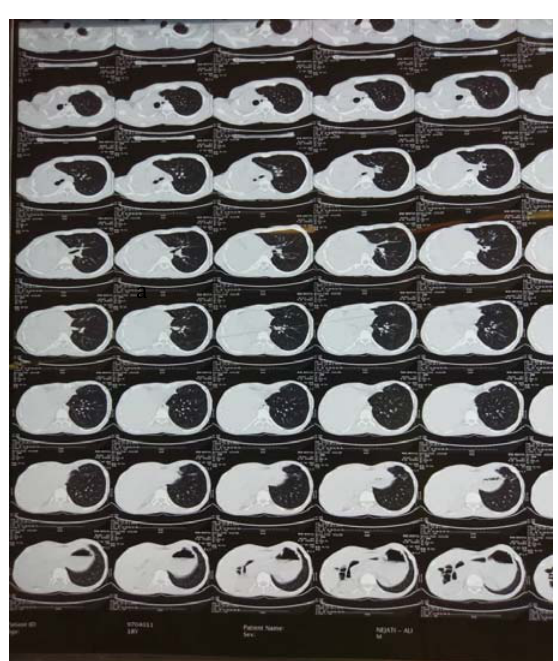
Figure 1. Computed tomography scan of patient with lung